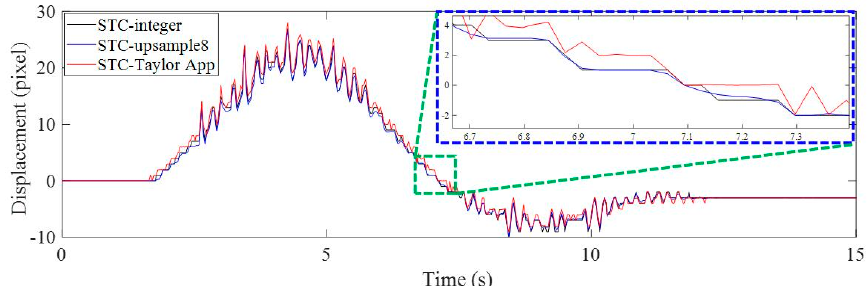
Figure 8. Vertical displacement time histories of P1 in pixel units using non-subpixel, image upsampling, and Taylor approximation techniques.